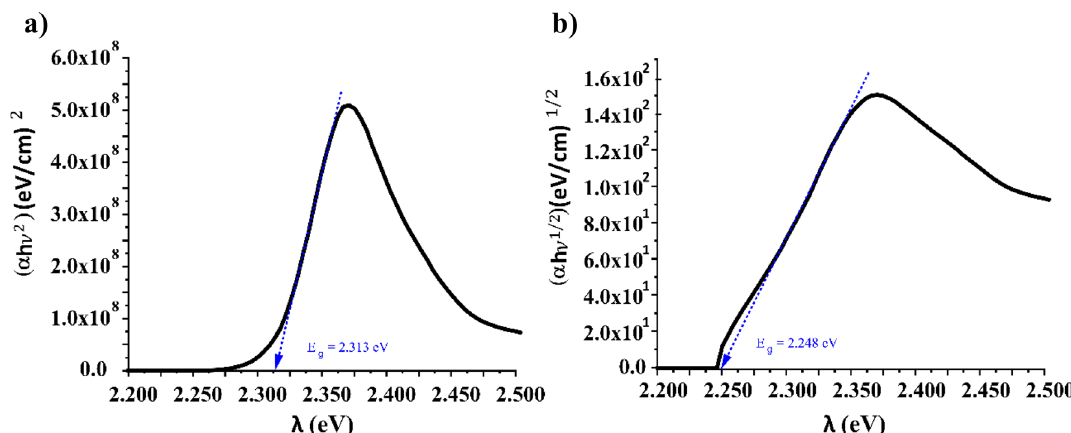
Figure 5. Relationship between (αhν)1/m (eV/cm)1/m and Energy (eV) of thin films of SU8 doped with Py580 with 1.8 µm of thickness at 20 mM for ( a ) m = ½ and ( b ) m = 2, for band gap energy calculation following Tauc’s